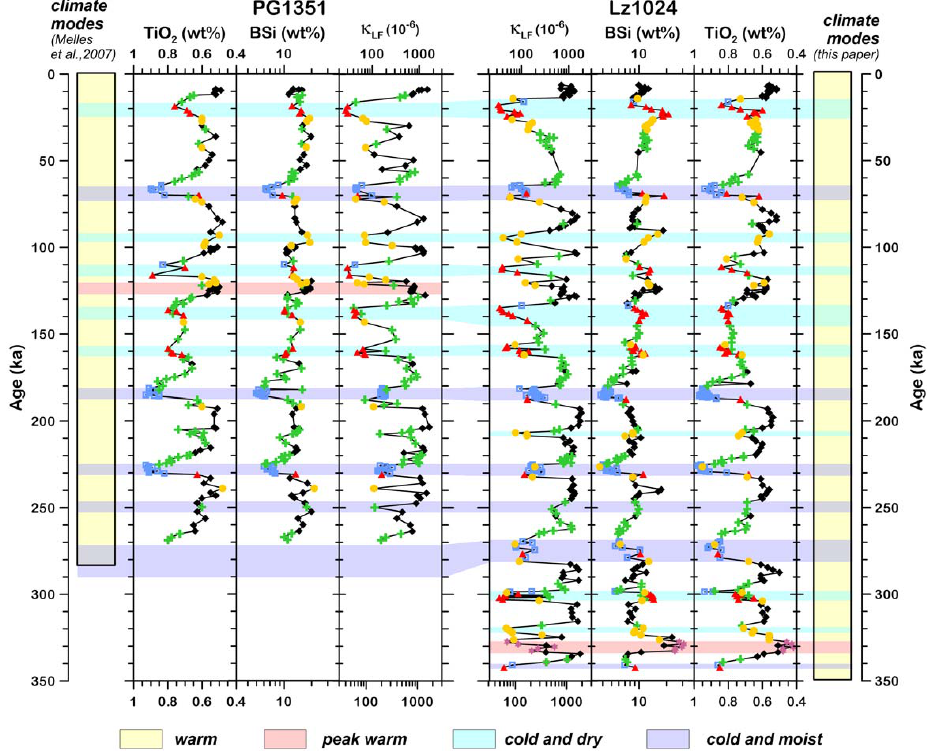
Fig. 6. Refining the boundaries of the climate modes at Lake El’gygytgyn by comparing the results of the cluster analysis for cores PG1351 and Lz1024 superimposed on the TiO 2 , the BSi and the magnetic susceptibility records versus age. Both TiO 2 curves are plotted on inverted axes. For legend of the clusters see Fig.